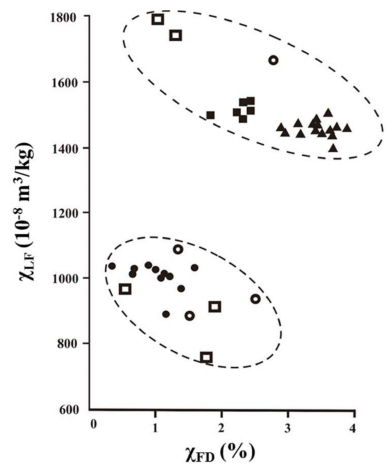
Figure 10. Plot between mass specific susceptibility ( χ LF ) and χ FD of lava samples from Ijen Crater (hollow square) and Mount Anyar (hollow circle), and dyke samples from Co. Fermanagh, Northern Ireland (site A: filled square, site C: filled triangle, site E: filled circle)